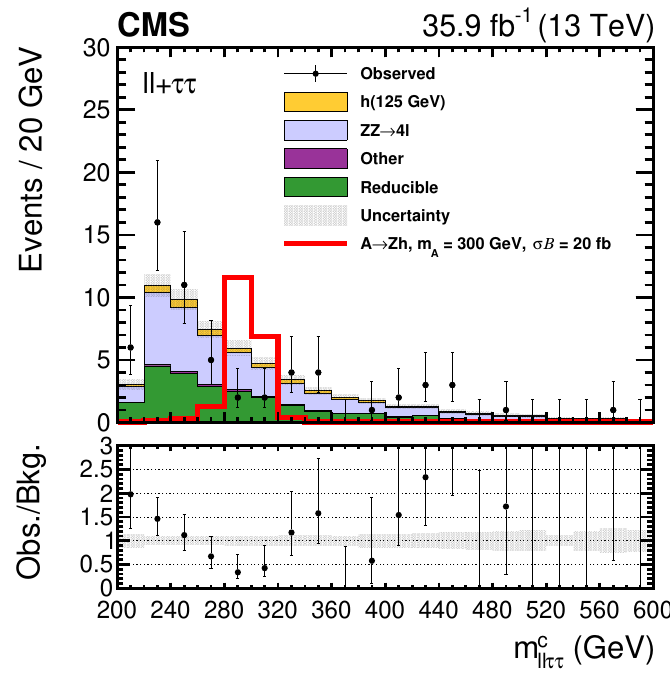
Figure 4 . The reconstructed mass m c distribution and uncertainties after a background-only (cid:12)t ‘‘ tt in all eight (cid:12)nal states. The (cid:12)nal states are included as separate distributions in the simultaneous (cid:12)t; combining them together is for visualization purposes only. The uncertainties include both statistical and systematic components. The expected contribution from the A ! Zh signal process is shown for a pseudoscalar Higgs boson with m = 300 GeV with the product of the cross section A and branching fraction of 20 fb and is for illustration only.